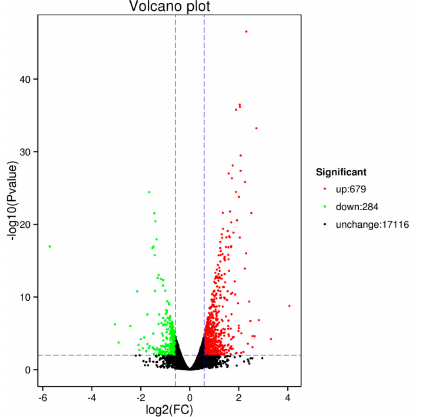
Figure 5. Volcanic map of differentially expressed genes.